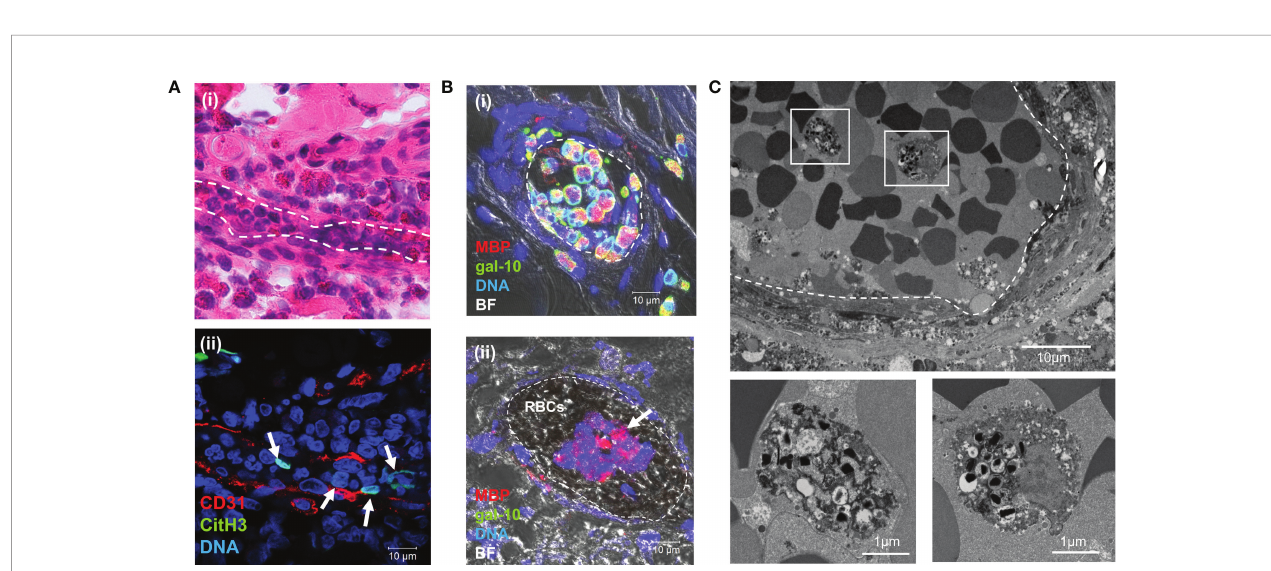
FIGURE 4 | EETosis in small vessel thrombi in patients with EGPA. In fl amed skin biopsy samples from patients with EGPA were observed using H&E staining (ai) and immunostaining for CD31 and CitH3 (aii) (identical sample). In fl ammatory cell in fi ltration including eosinophils was observed in the perivascular area and occluding small vessels [dashed line in (ai) ]. Net-like CitH3-positive nuclei were present in small vessels ( aii , arrows). (B) Sural nerve biopsy samples were stained to detect the eosinophil granule protein MBP, eosinophil cytoplasmic protein galectin-10 (gal-10), and DNA. Merged immuno fl uorescence and bright fi eld (BF) images indicated clustering of intact eosinophils in the intravascular space (bi) and clusters of EETotic eosinophils in thrombus ( bii , arrow). Clustered red blood cells (RBCs) were also observed. (C) TEM of sural nerve tissues showed lytic eosinophils with EETotic morphologies in small vessel thrombus (dashed line). Boxed areas in upper panel are magni fi ed in lower